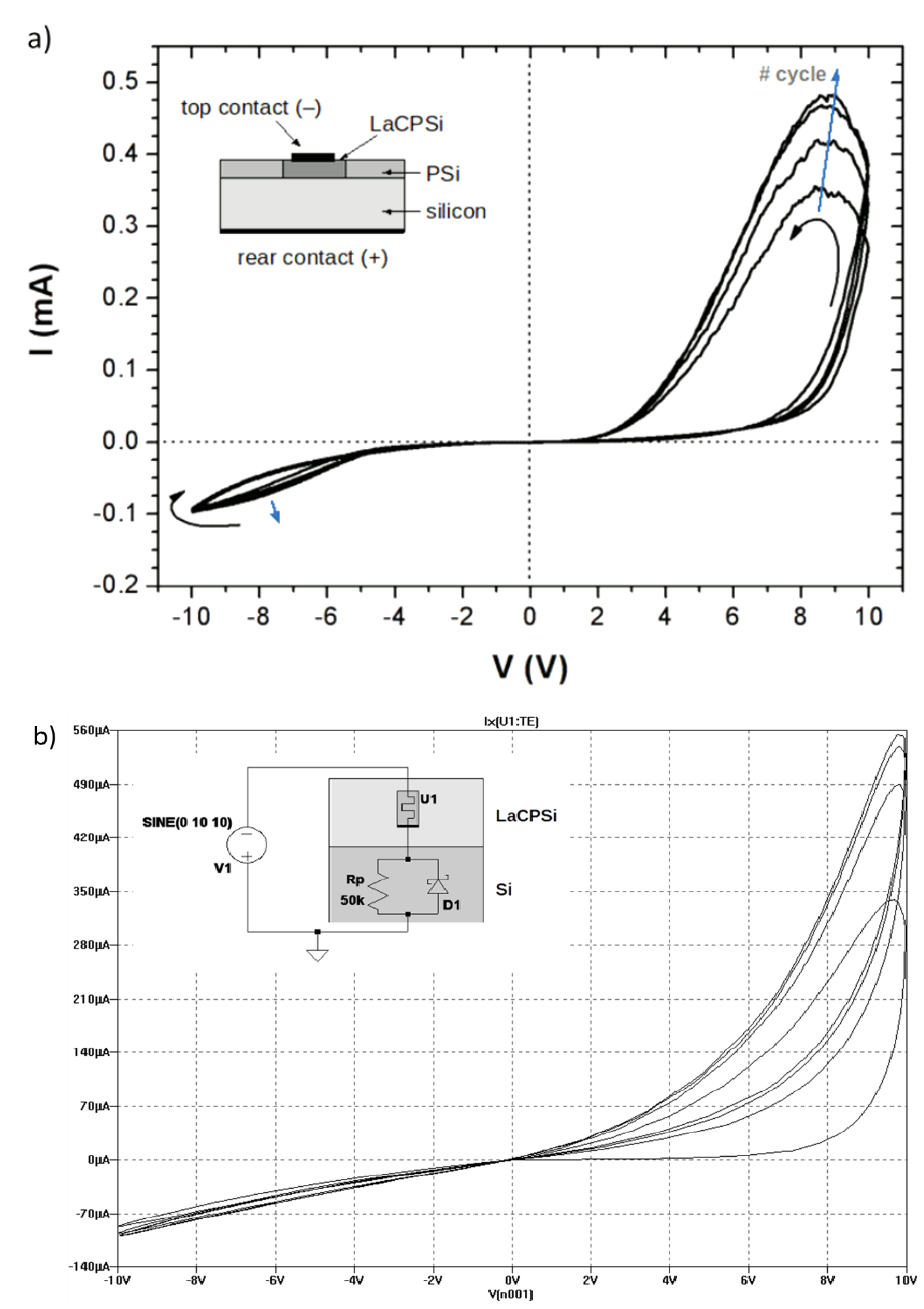
Figure 1. ( a ) I-V plot of a laser carbonized porous silicon (LaCPSi) structure. Voltage was swept sinusoidally with a 10 V amplitude at a rate of 5 V / s. Arrows indicate the voltage path. The pinched hysteresis loop typical of memristors is evident. The inset shows an schematic view of the device. ( b ) LTSpice simulation of a LaCPSi / Si structure. The inset shows the equivalent circuit used for the